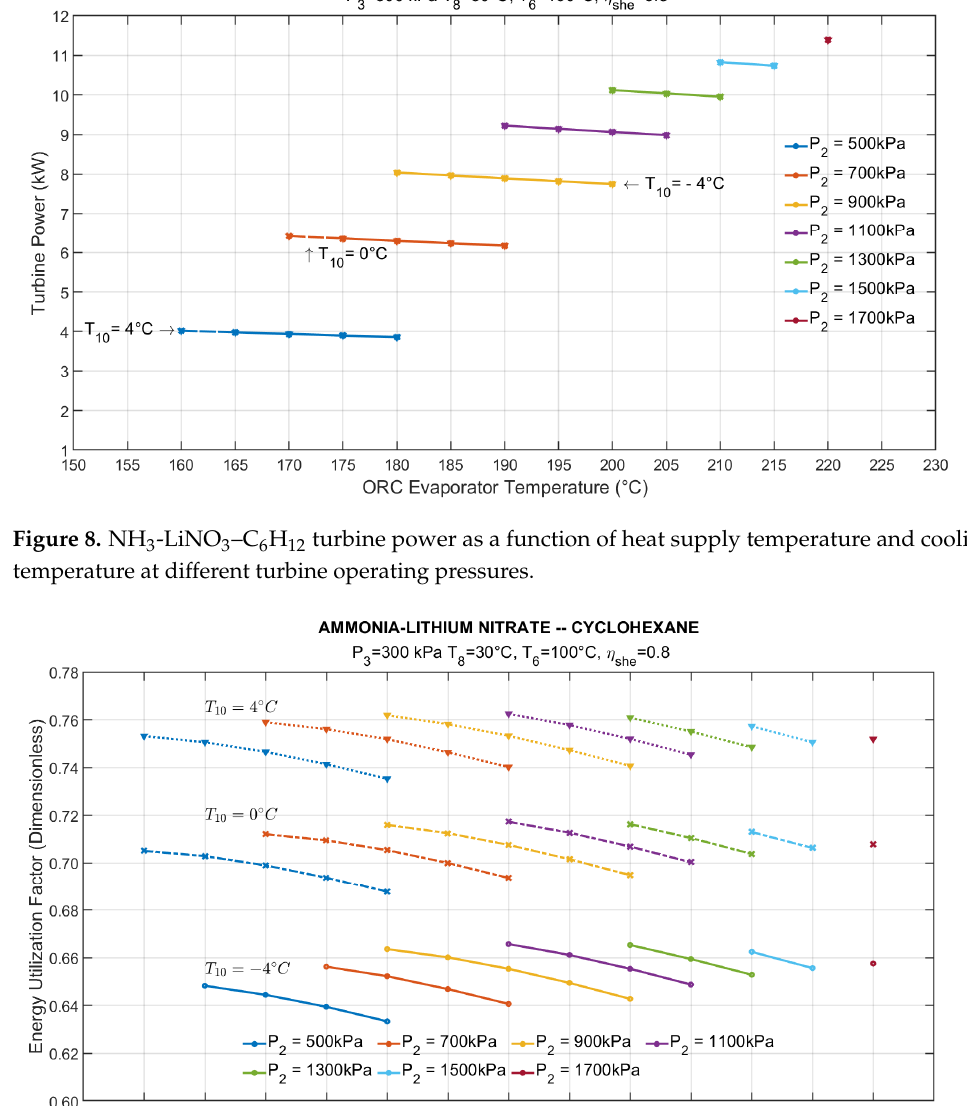
Figure 8. NH 3 -LiNO 3 --C 6 H 12 turbine power as a function of heat supply temperature and cooling temperature at di ff erent turbine operating pressures.